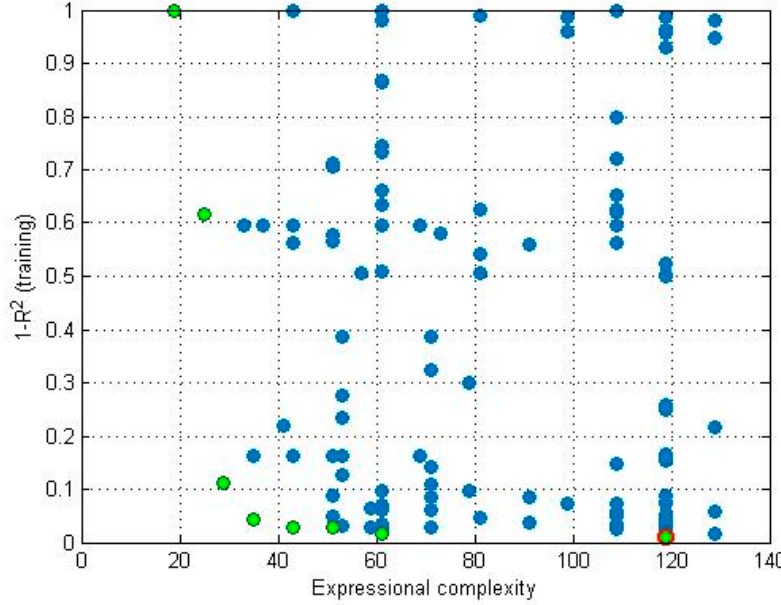
Figure 11. Expressional complexity of the proposed Single-Gene model.